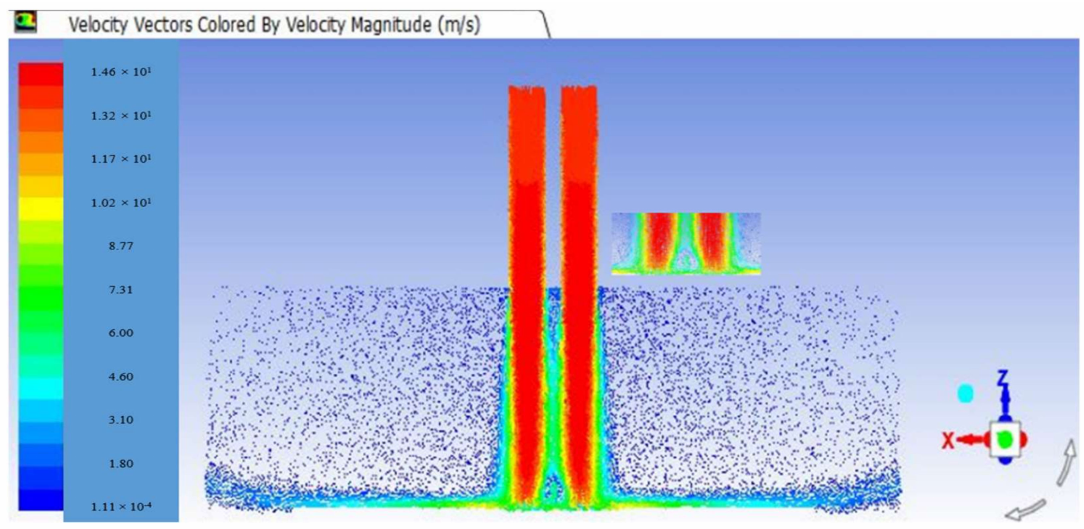
Figure 21. Velocity vectors colored by the velocity magnitude for the twin impingement jet mechanism at the Nozzle-Nozzle spacing equal to 1 cm and the Nozzle-Plate distance equal to 11